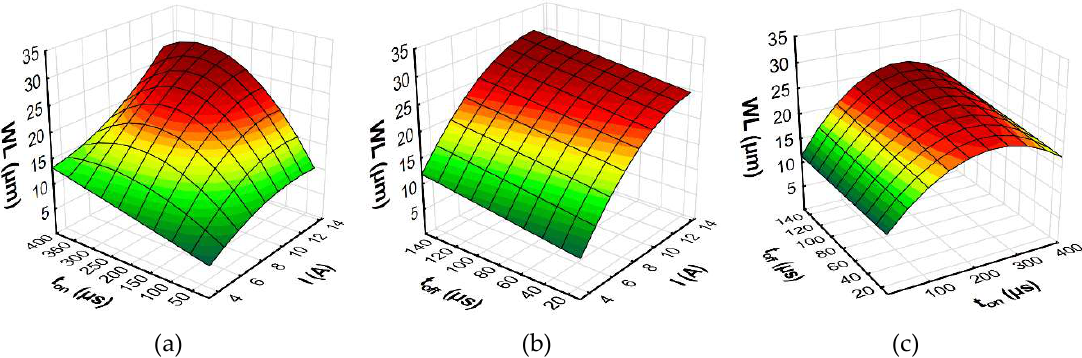
Figure 15. The estimated response surface plot for the WL: ( a ) constant t off = 80 μs; ( b ) constant t on = 206 μs; and ( c ) constant I = 8.5 A.